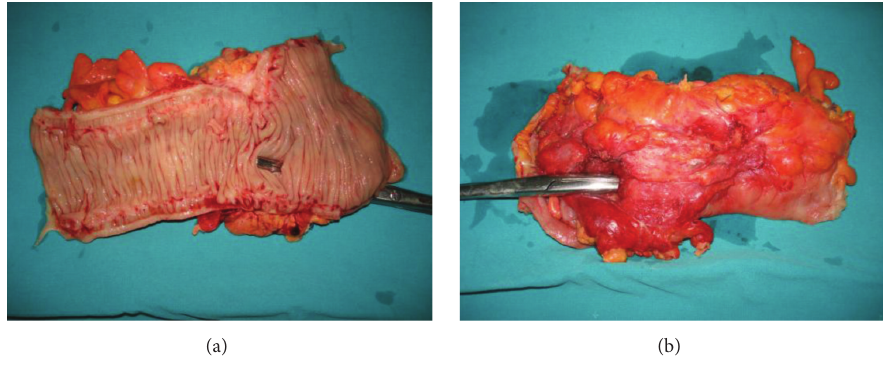
Figure 5: Postoperative excised left colon specimen. Table 1: Lumbar abscesses due to diverticular perforation: three reported cases and treatment of choice. Authors Green and Joypaul [11] Coulier et al. [12] Paramythiotis et